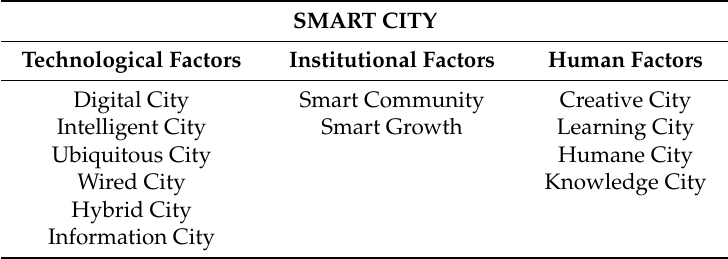
Table 1. Smart city core